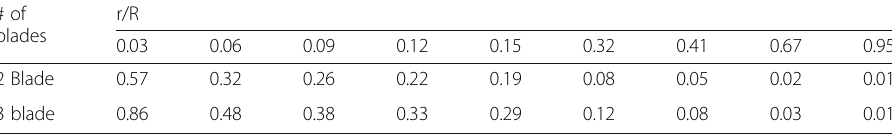
Table 2 Blade solidity factor along blade span # of